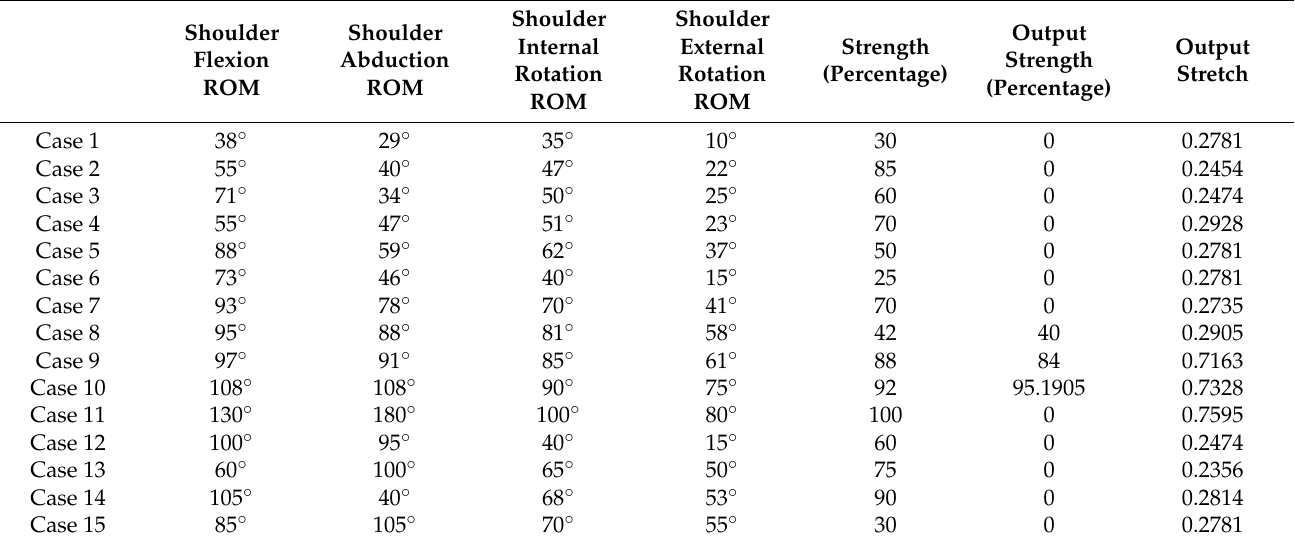
Table 6. Presents the results of the complete system, with shoulder joint motions and muscle strength as inputs and intensity of stretching and strengthening exercise as